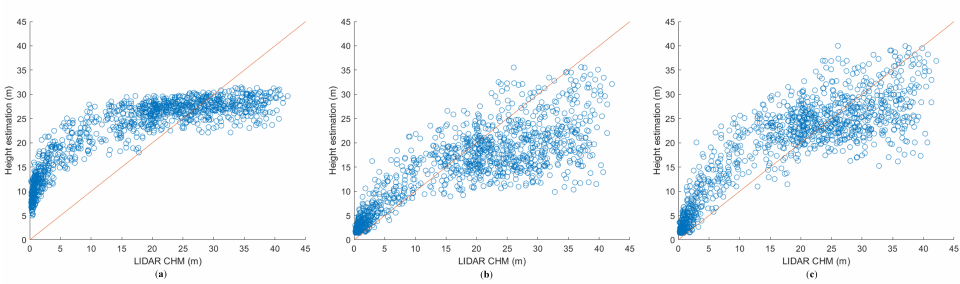
Figure 14. Validation of the inversion results of ( a ) the RVoG model, ( b ) the RVoG-vtd model and ( c ) the GRVoG-vtd model versus LiDAR-based height.